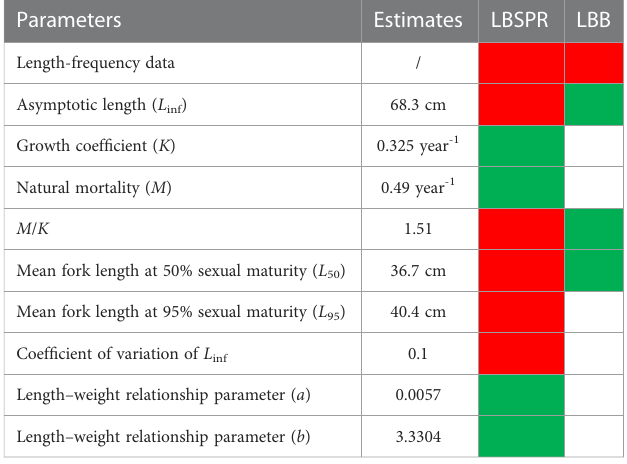
TABLE 1 Summary of data requirements for LBB and LBSPR methods (red boxes represent required data; green boxes represent optional data).